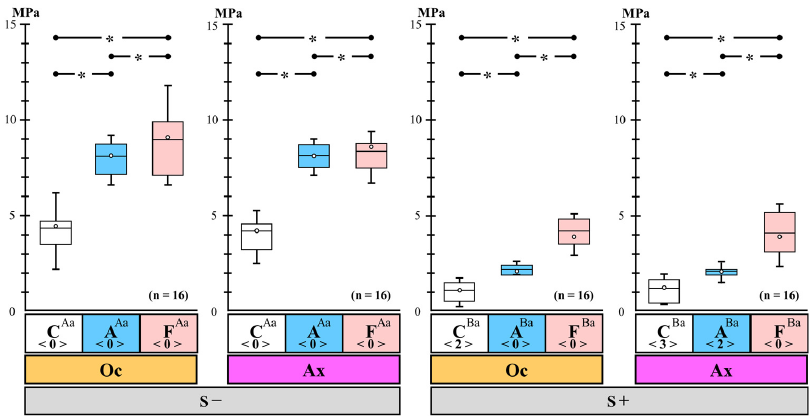
Figure 2. Differences in the micro-tensile bond strength on the occlusal and axial walls among the three types of immediate dentin sealing with and without cyclic loading. The box indicates the spread of the data between the first and third quartiles. The central horizontal line and the circle show the median and the mean, respectively. Maximum and minimum values are indicated by whiskers. The number of pretesting failure specimens is indicated by angle brackets. The asterisks (*) among the three types of immediate dentin sealing indicate statistically significant differences at p < 0.05. Different uppercase letters between two conditions with and without cyclic loading in the same immediate dentin sealing and in the same abutment wall indicate statistically significant dif- ferences at p < 0.05. Different lowercase letters between two different abutment walls in the same immediate dentin sealing and in the same cyclic loading condition indicate statistically significant differences at p < 0.05.